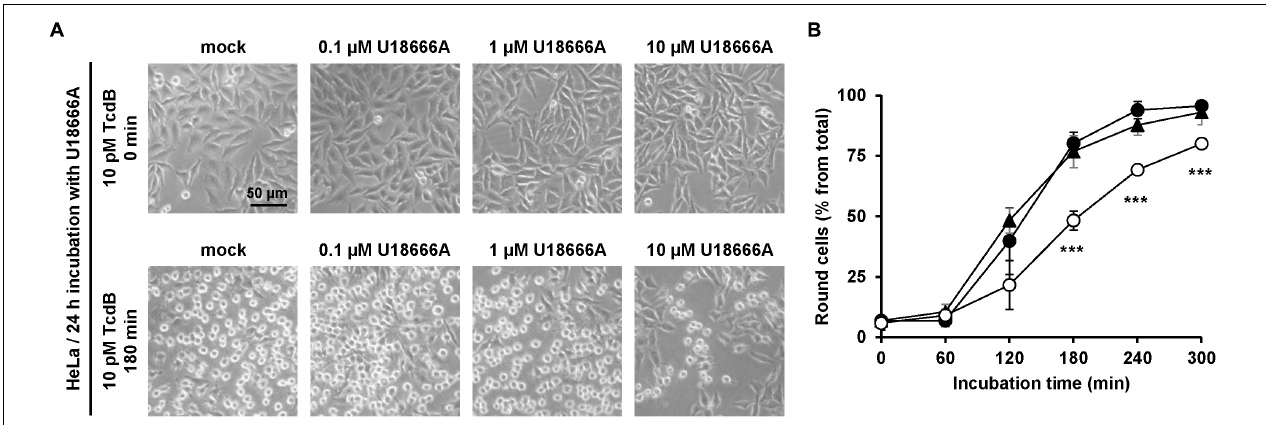
FIGURE 1 | Effect of U18666A on intoxication of HeLa cells by TcdB. (A) HeLa cells were pretreated for 24 h with increasing concentrations of U18666A as indicated or were left untreated (mock), prior to addition of 10 pM TcdB. Microscopic images shown were taken after time point 0 min (upper row) and 180 min (lower row). (B) Quantification of the TcdB-induced cell rounding over time in mock-treated (black filled circles) and 24 h U18666A-pretreated HeLa cells (1 µ M, black filled triangles; 10 µ M, white filled circles). Graph shows mean (percentage values of round cells) from three experiments performed in parallel in independent wells. Error bars represent ± SD. Asterisks indicate statistical significance compared to control (mock-treated HeLa cells) with *** p < 0.001.